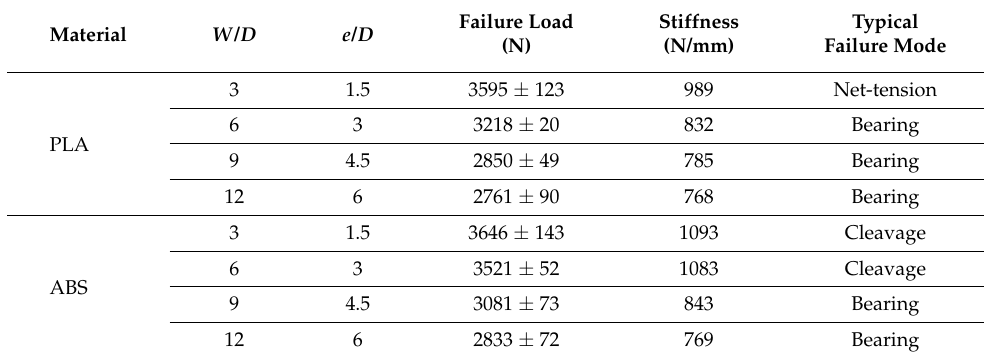
Table 2. The results of the examined 3D-printed specimens.